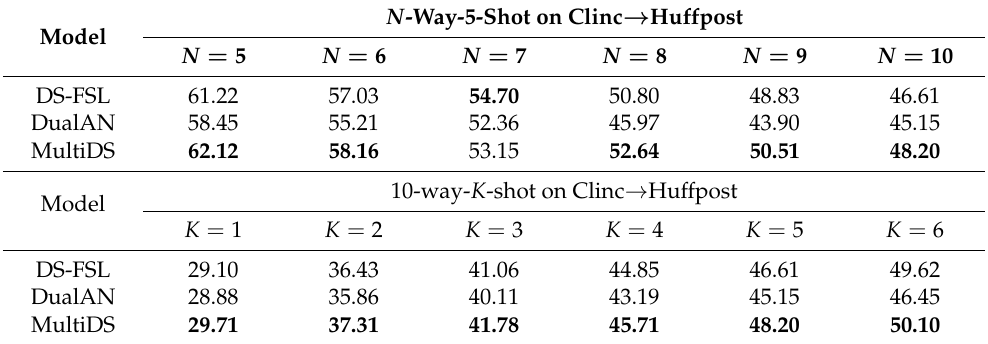
Table 8. Model stability verification on Clinc → Huffpost. The best results are emphasized using bold fonts. Model